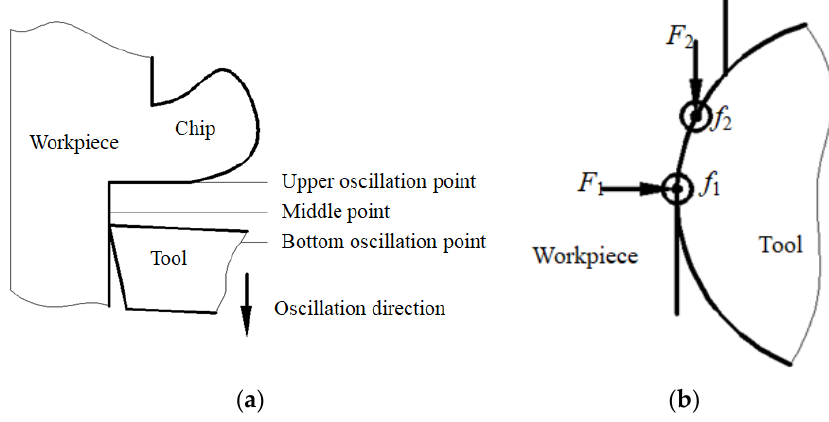
Figure 14. Schematic diagram of force analysis at the stage of diamond tool withdrawing; ( a ) Front view; ( b ) Top view.